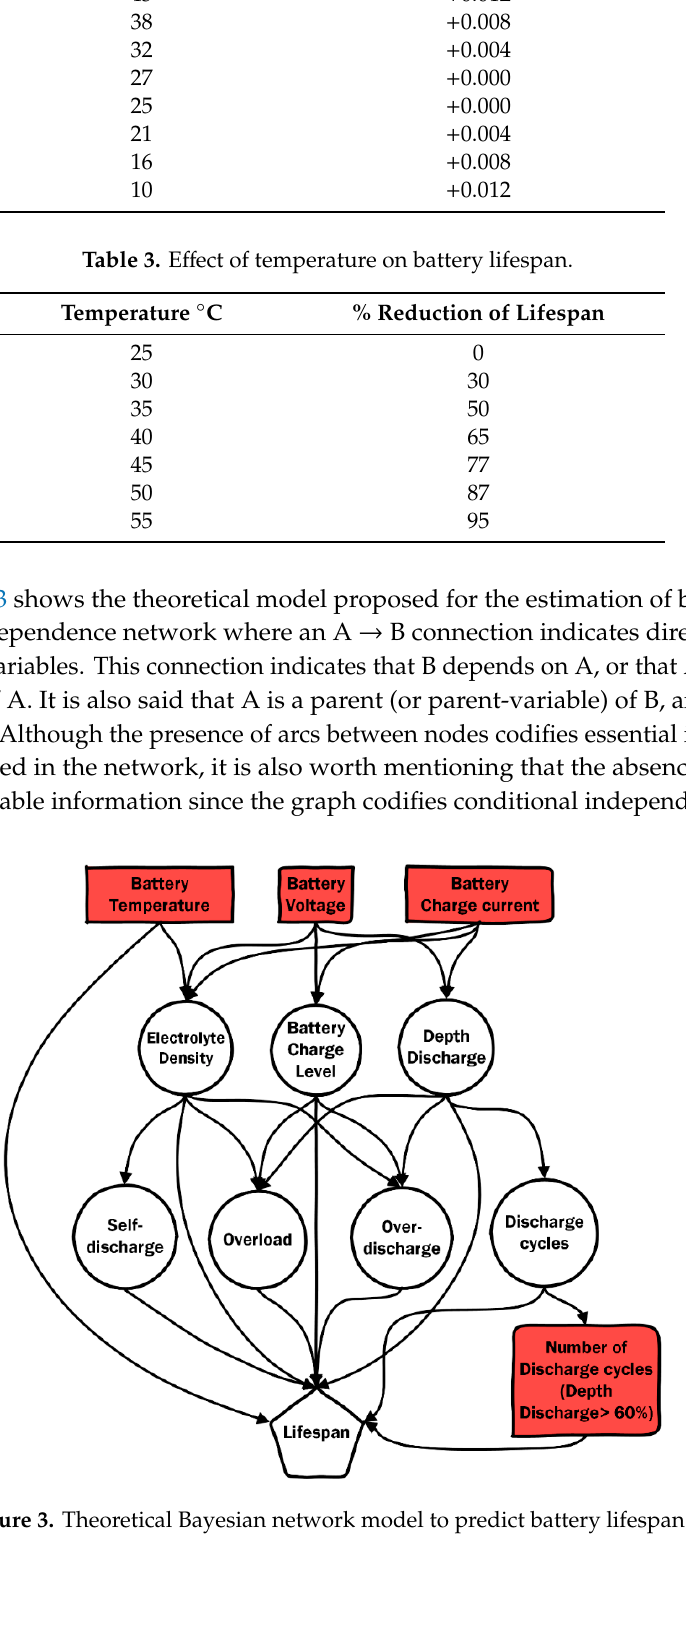
Table 3. Effect of temperature on battery lifespan.